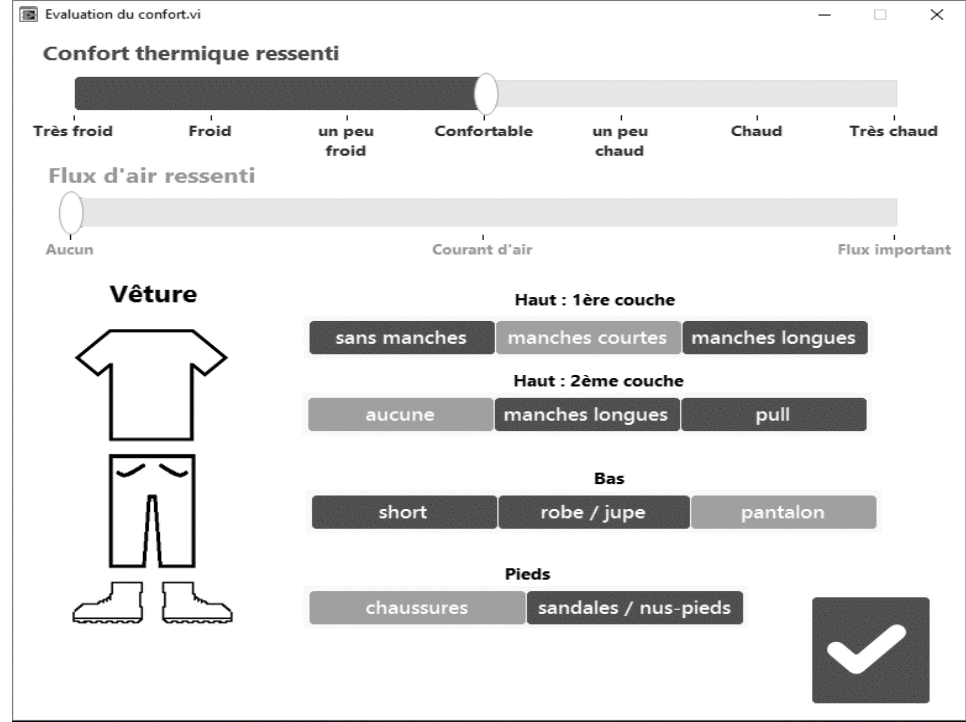
Figure 8. UI of the thermal comfort vote device.